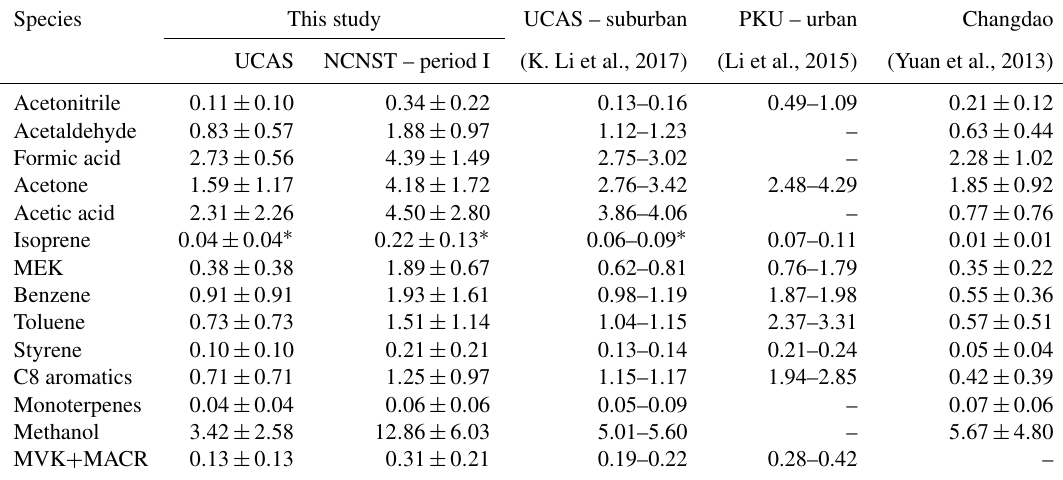
Table 1. VOC concentrations at urban and suburban sites and comparison to previous studies.